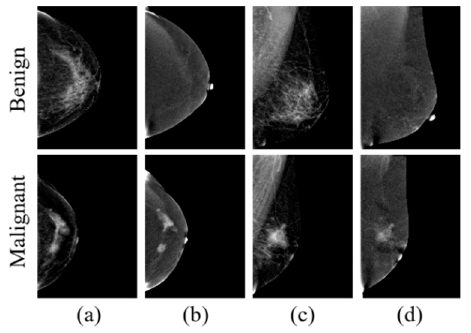
Figure 1. Examples of contrast-enhanced spectral mammography images: ( a ) craniocaudal low-energy image (CC-LE); ( b ) craniocaudal dual-energy subtracted image (CC-DES); ( c ) mediolateral oblique low-energy image (MLO-LE); ( d ) mediolateral oblique dual-energy subtracted image (MLO-DES).